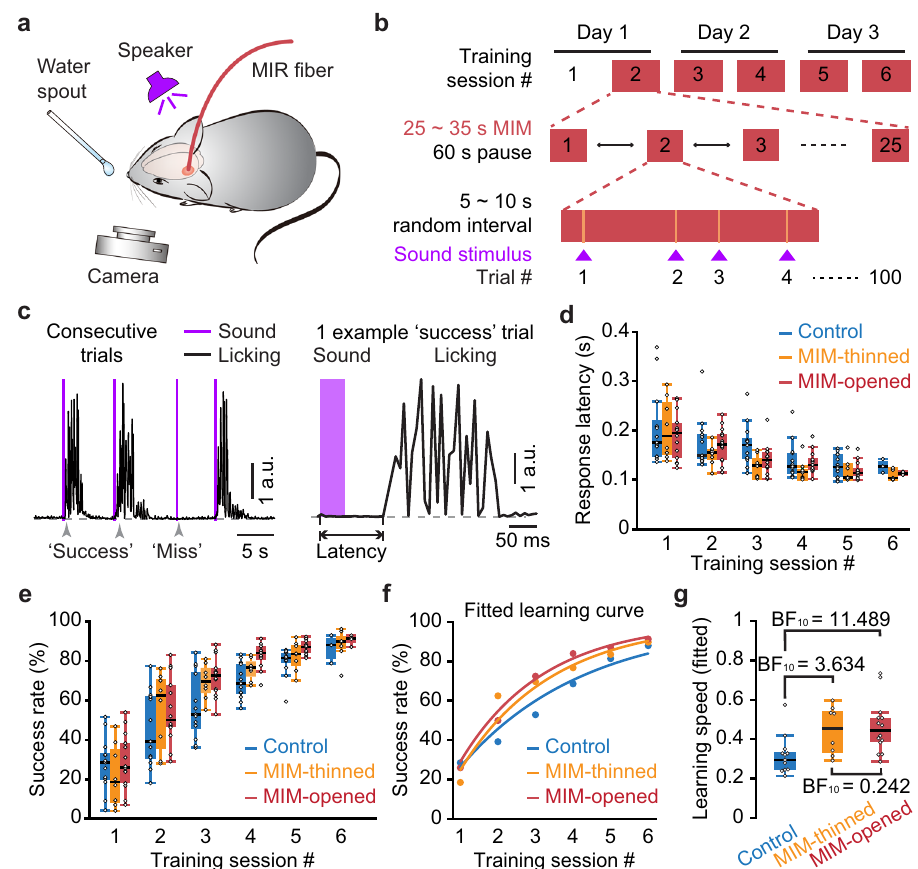
Fig. 3 MIM in the auditory cortex accelerates learning during a sound-licking associative training task. a Schematic illustrating the general scheme for the experiments using MIM in a sound-water associative training task. b Detail of the experimental protocol for MIM application throughout the